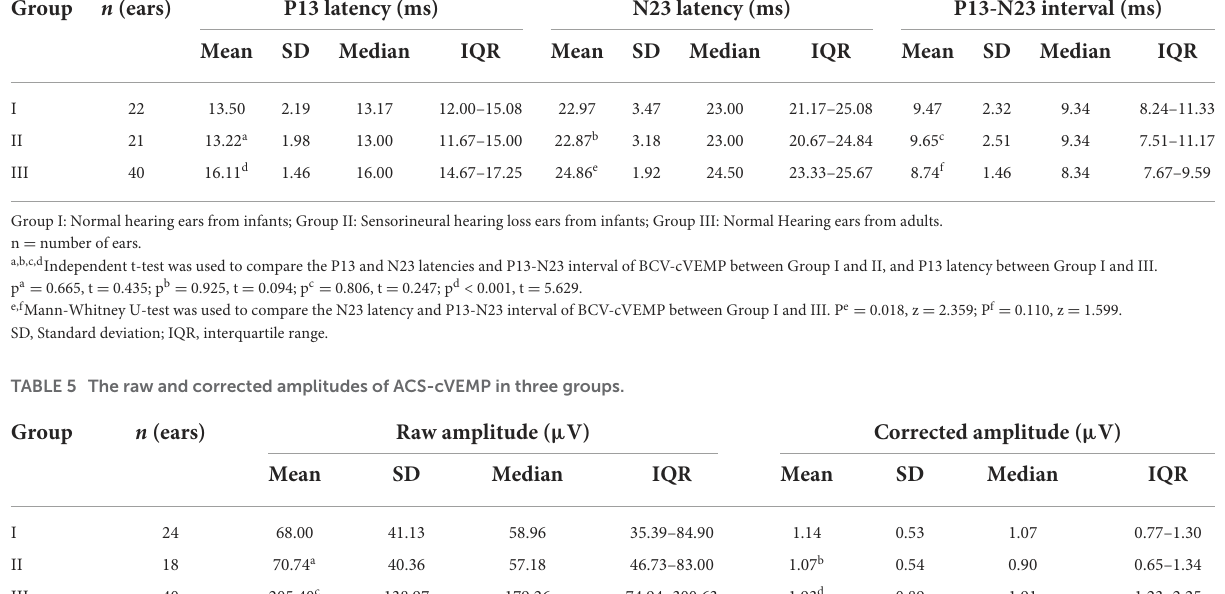
TABLE 4 The P13 and N23 latencies and P13-N23 interval of BCV-cVEMP in three groups. Group